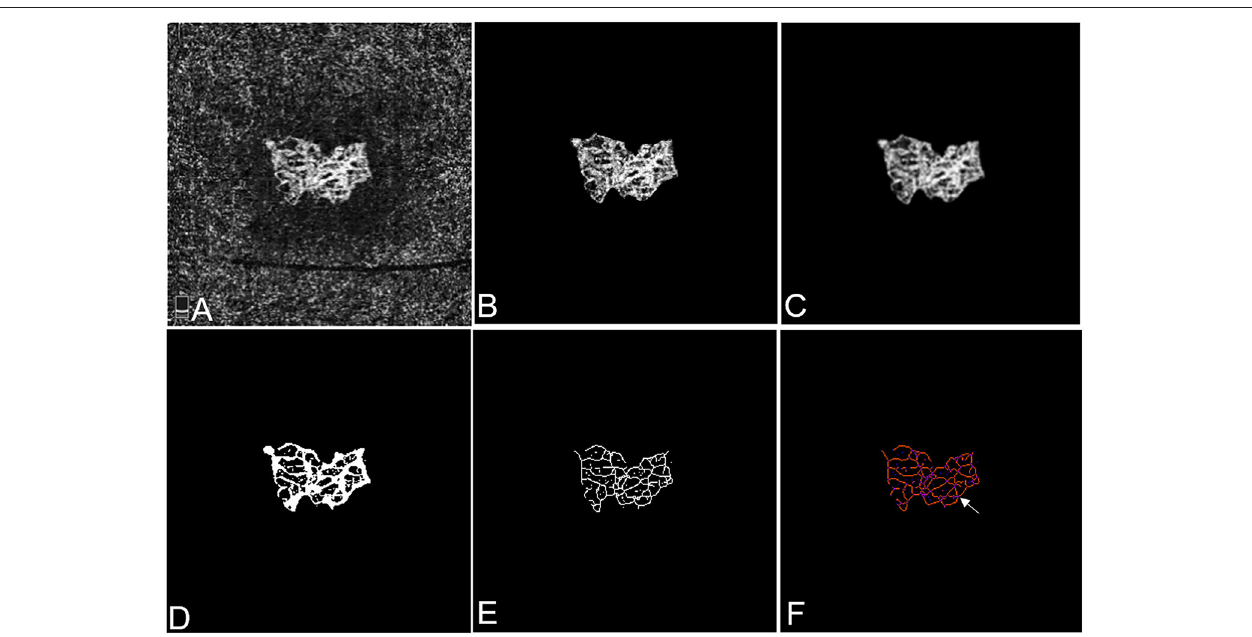
FIGURE 1 | Representative OCTA images of mCNV before and after cropping, binarisation, and skeletonisation in Patient #18, a 60-year-old female (refractive error − 15.50 diopters) in the right eye. (A) OCTA image showing the entire thickness mCNV lesion after manual adjustment of segmentation. (B) The full extent of mCNV was manually delineated, and the mCNV area was measured by counting the pixels contained within the contour. (C) The Gaussian kernel was used to reduce the image noise and obtain a smooth image. (D,E) The binary OCTA image was formed by Frangi vesselness filter and local adaptive thresholding and used for calculating vessel area, fractal dimension and vessel lengths. Vessel density was calculated using vessel area and mCNV area. (F) Tagged Skeleton image was used to calculate the numbers of vessel junctions (white arrow). Junction density was calculated by dividing the vessel junction by the vessel length. Images (B–E) were acquired by MATLAB program and image (F) was acquired by IMAGE J